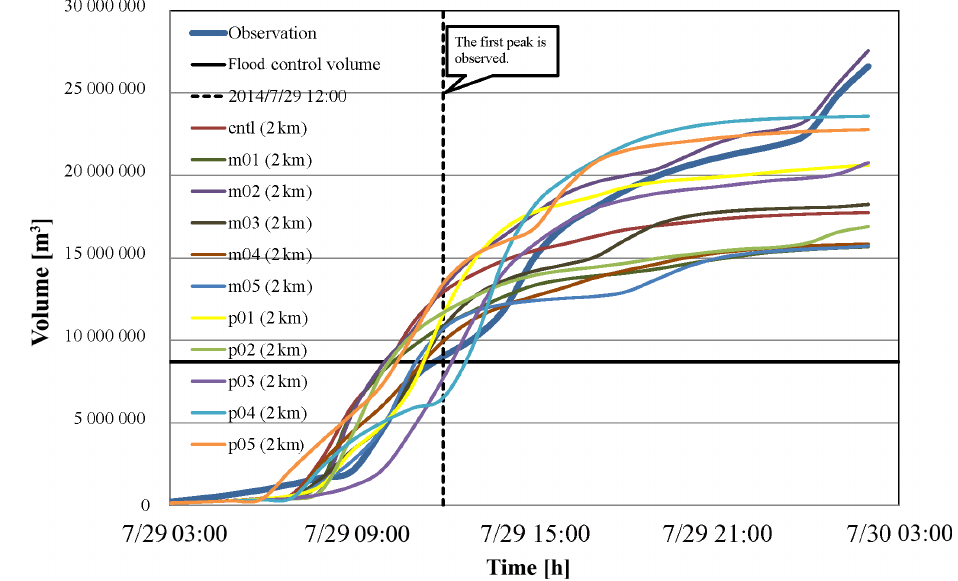
Figure 19. Inflow volume into the reservoir based on observation and ensemble simulations with rainfall position